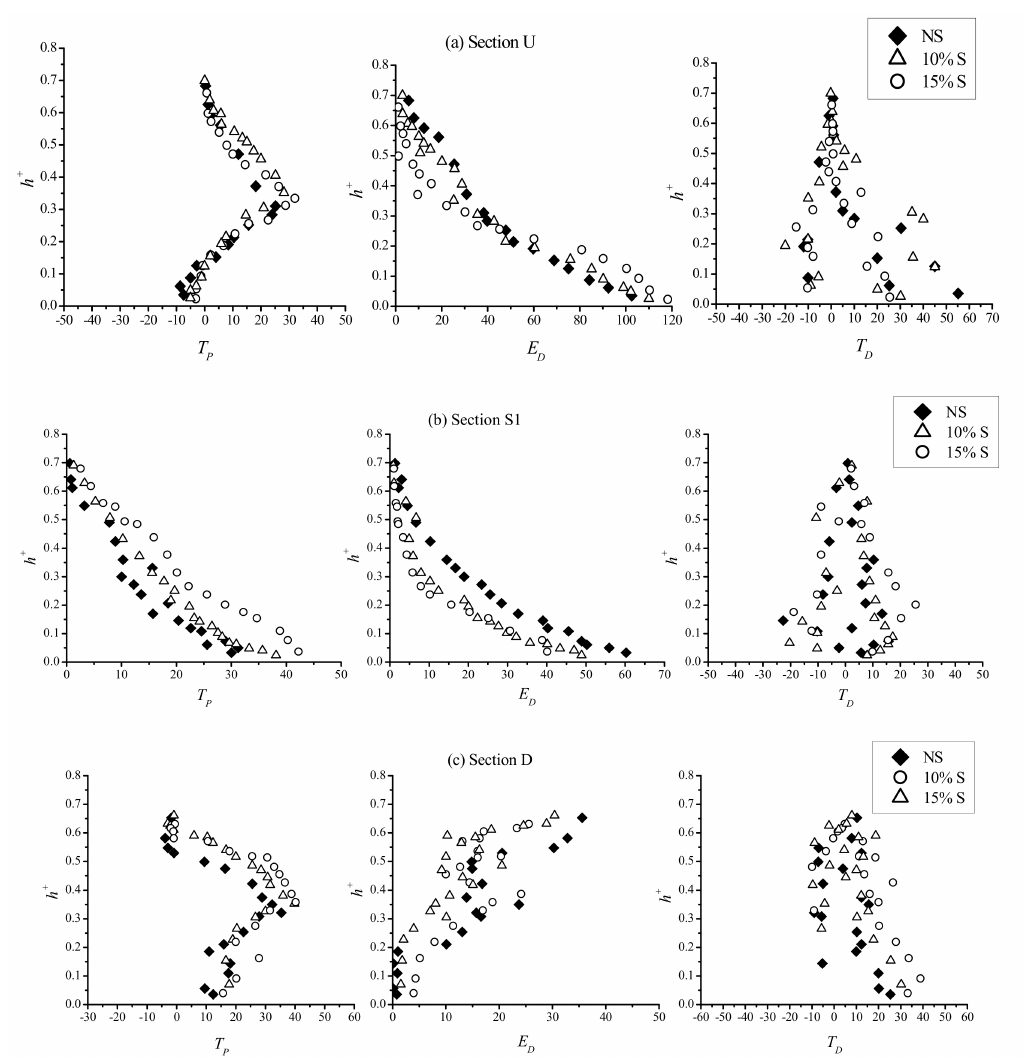
Figure 5. Non-dimensional distributions of turbulent production ( T P ), turbulent kinetic energy dissipation ( E D ), and di ff usion ( T D ) for NS, 10% S, and 15% S in the following sections: ( a ) U; ( b ) S1; ( c )